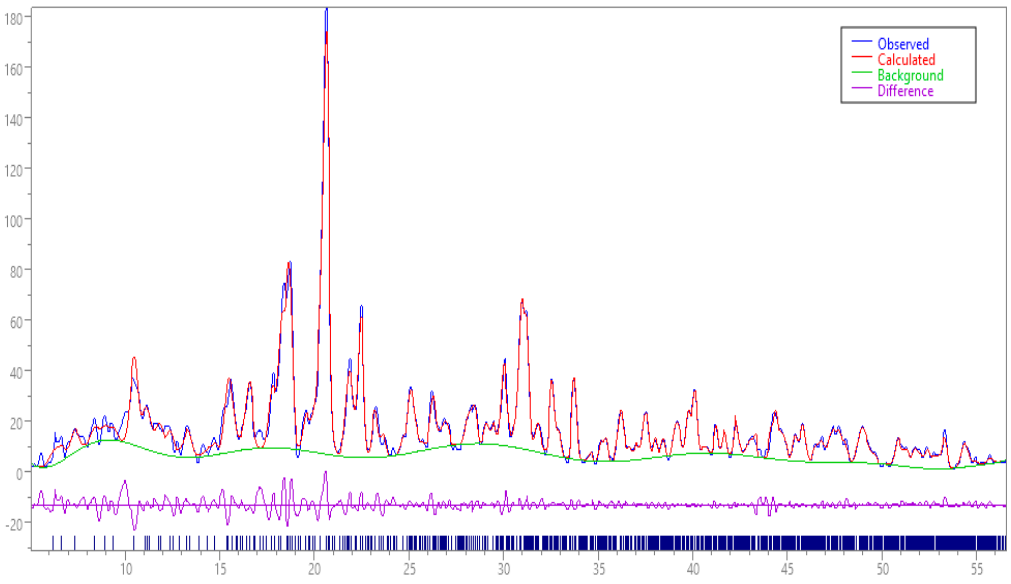
Figure 9. (Red Color line) Rietveld plot for refinement of pXRD PCCAg 0 NPs. Refinement PXRD patterns convert the approximate structure of PCCAg 0 NPs crystal into an actual structure, see Figure 10.